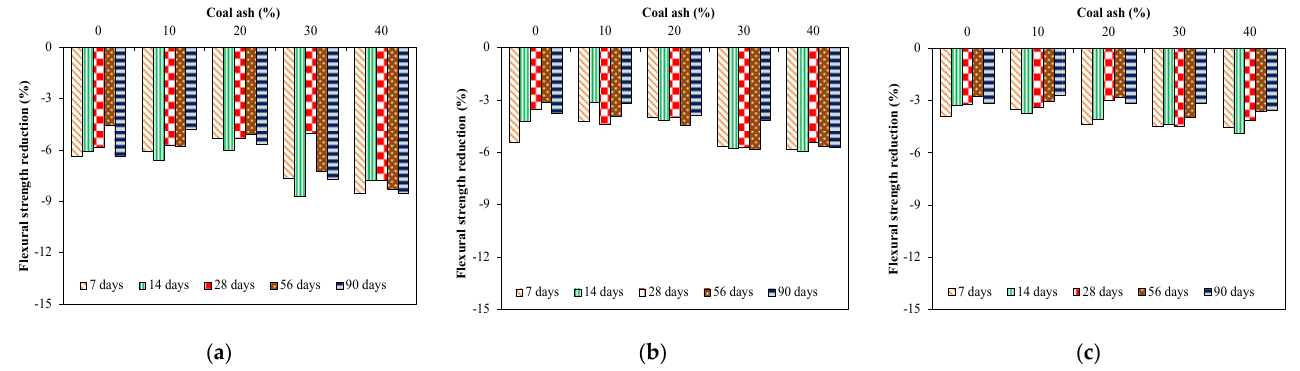
Figure 16. Flexural strength reduction due to ASR conditions: ( a ) no fibers; ( b ) 0.5% fibers; ( c ) 1% fibers.